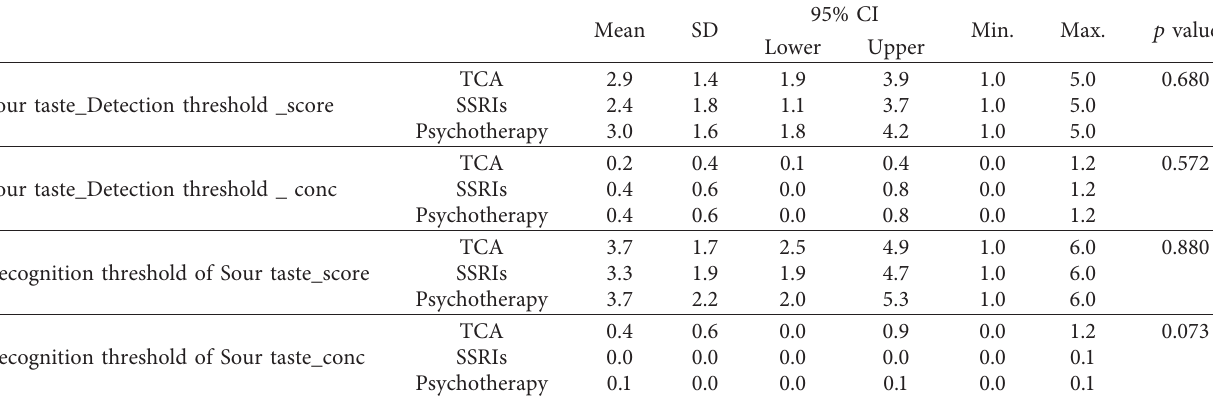
Table 4: Descriptive statistics and one-way ANOVA for sour detection and recognition thresholds scores and concentrations among the tested groups.